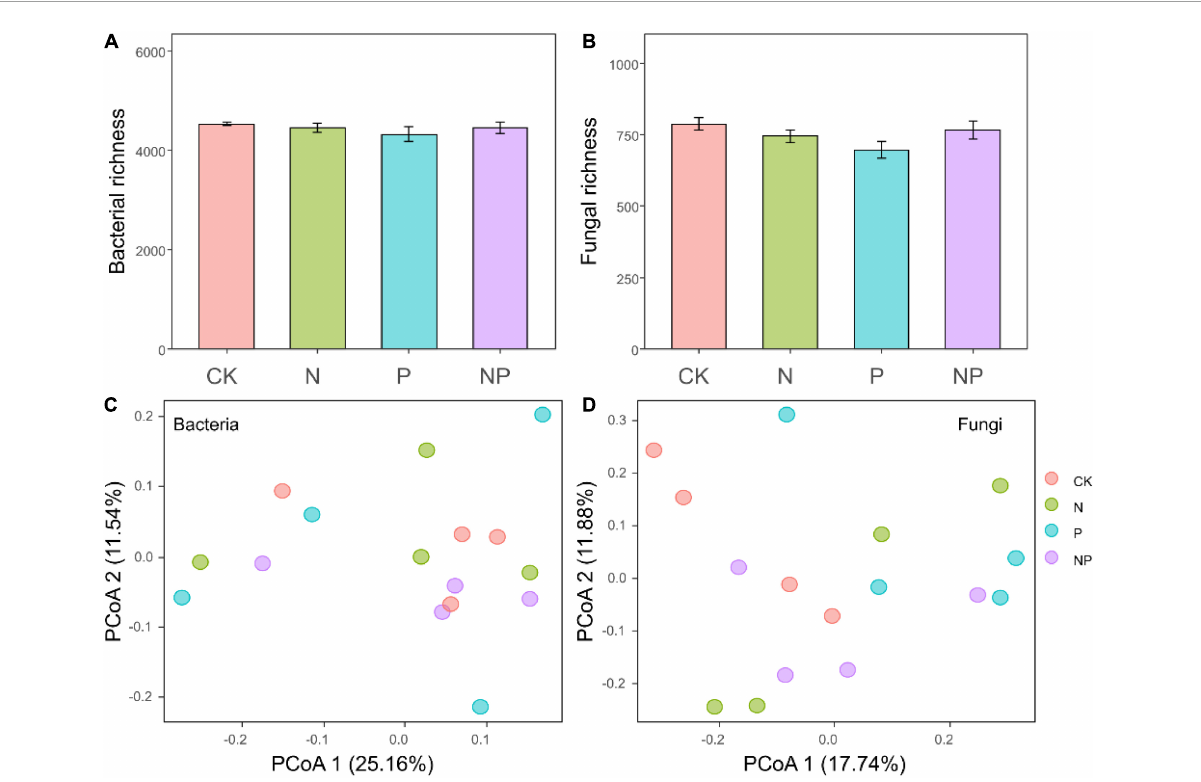
FIGURE3 Bacterial richness (A) and fungal richness (B) under different treatments. Bars represent means ± SEs. Principal coordinate analysis ordination (PCoA) plot based on a Bray–Curtis dissimilarity matrix of bacterial communities (C) and fungal communities (D) under different